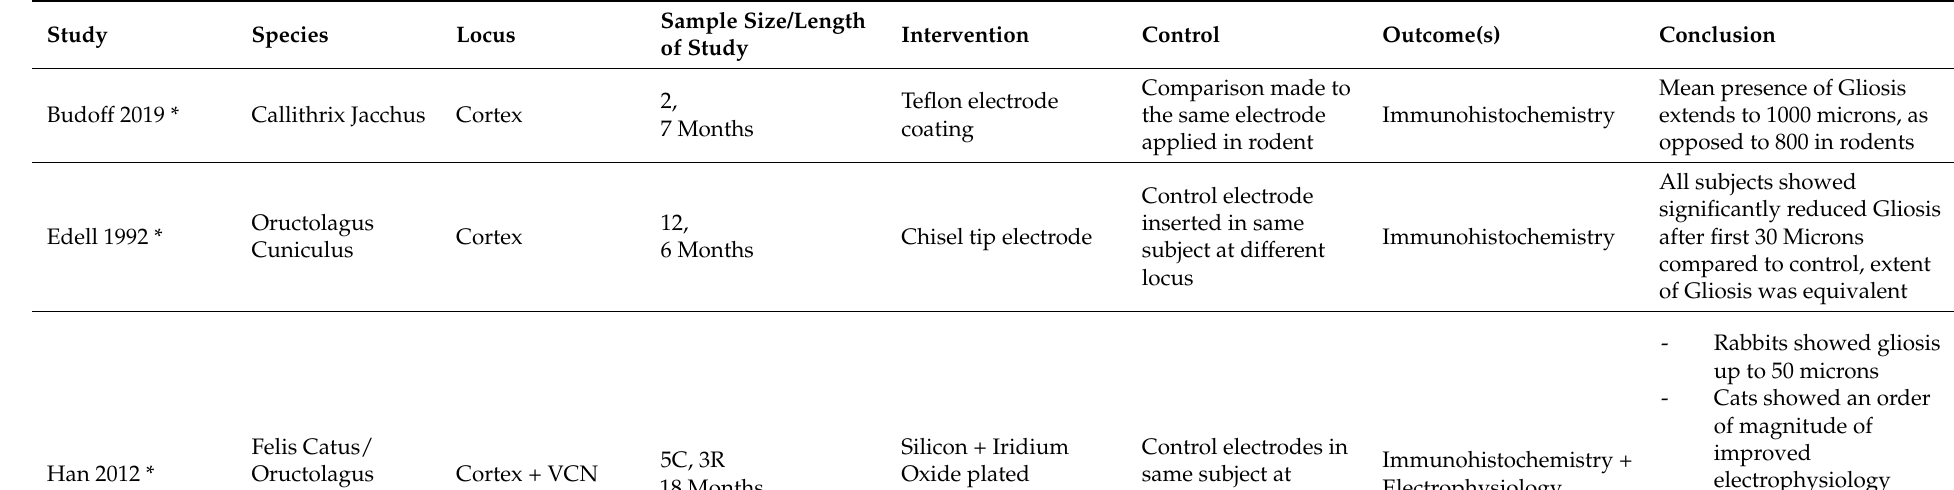
Table 1. Summary of included articles. * are articles studying cortical